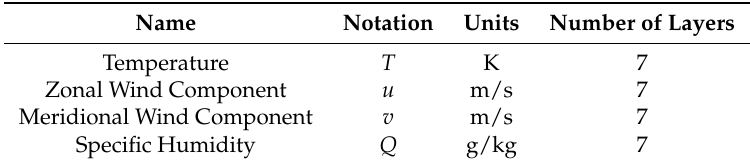
Table 1. Physical variables of the SPEEDY